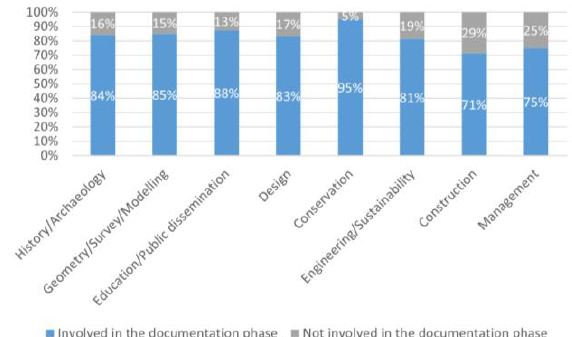
Figure 13: Involvement in the documentation phase by interest